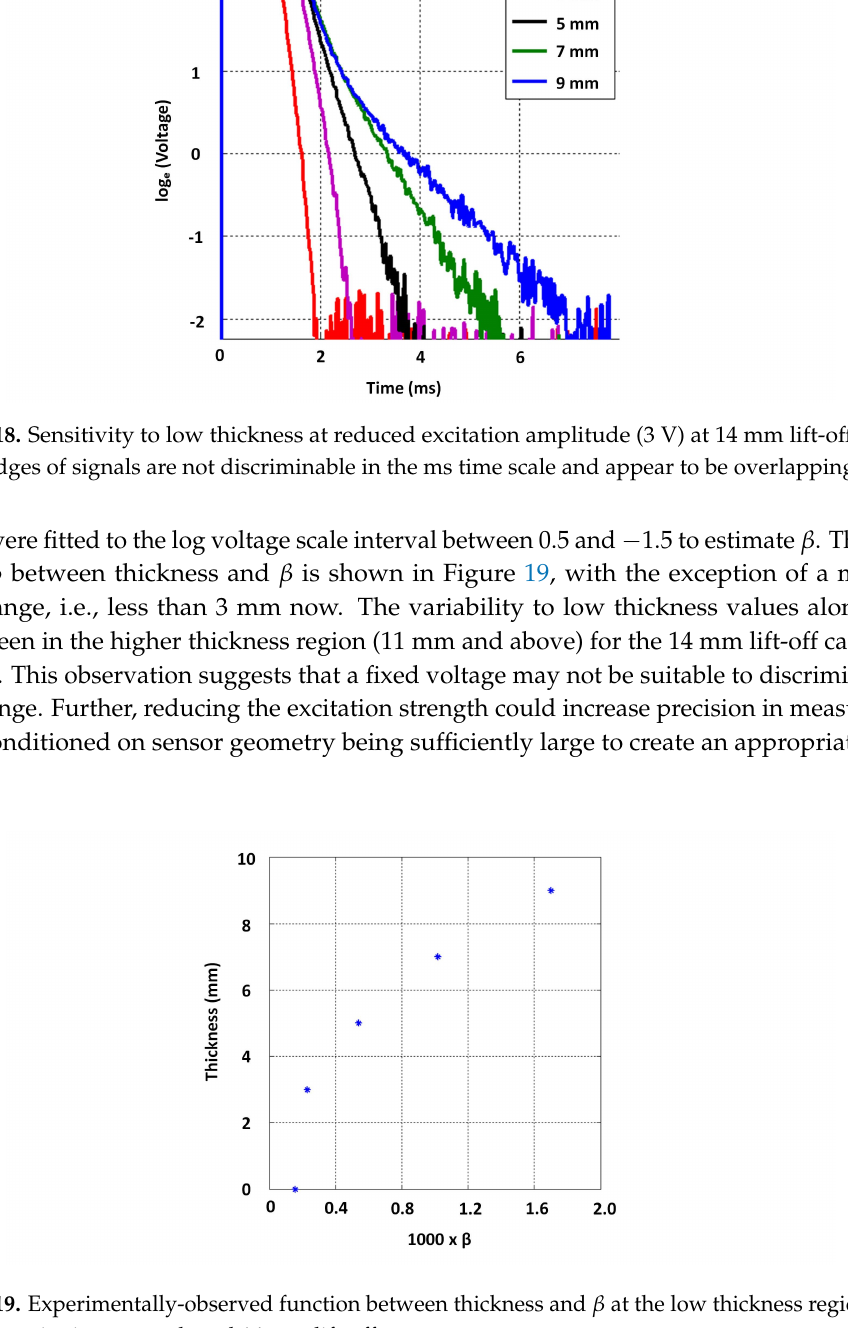
Figure 19. Experimentally-observed function between thickness and β at the low thickness region with reduced excitation strength and 14 mm